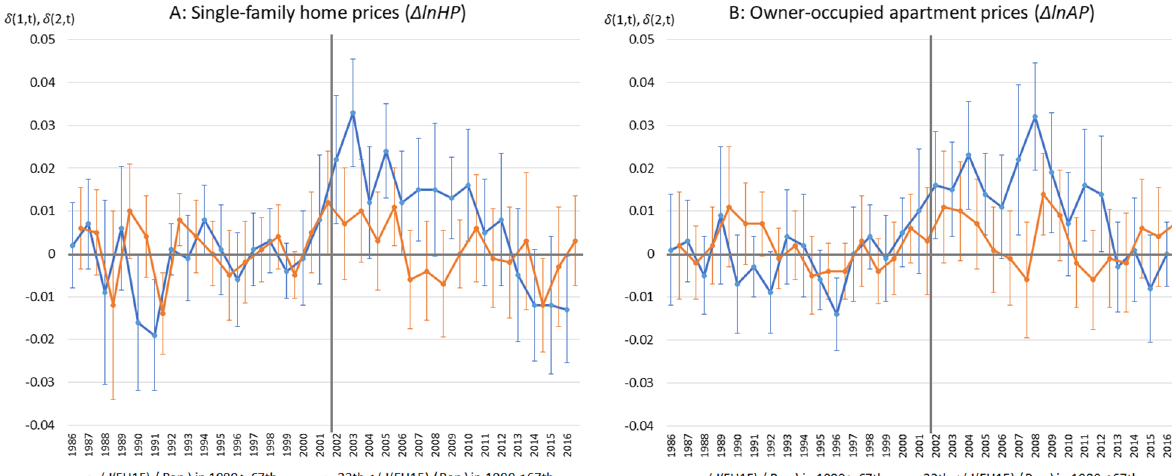
Fig. 6 House prices and immigration—MS-regions from 1985–2016: Event study by year. Notes: The figure shows the estimated coefficients δ 1, t and δ for single-family homes. In Panel B, the dependent variable is the annual change in the log of the price index for owner-occupied apartments. All regressions include year fixed effects and the annual change in the unemployment rate lagged by one year as a control variable. Standard errors are clustered by MS-regions. The 67th and 33rd percentiles of the distribution of the stock of EU-15 foreigners relative to total population in year 1980 across MS-regions are used as cut-off levels. Source: Own calculations based on data from Wüest Partner and Federal Statistical